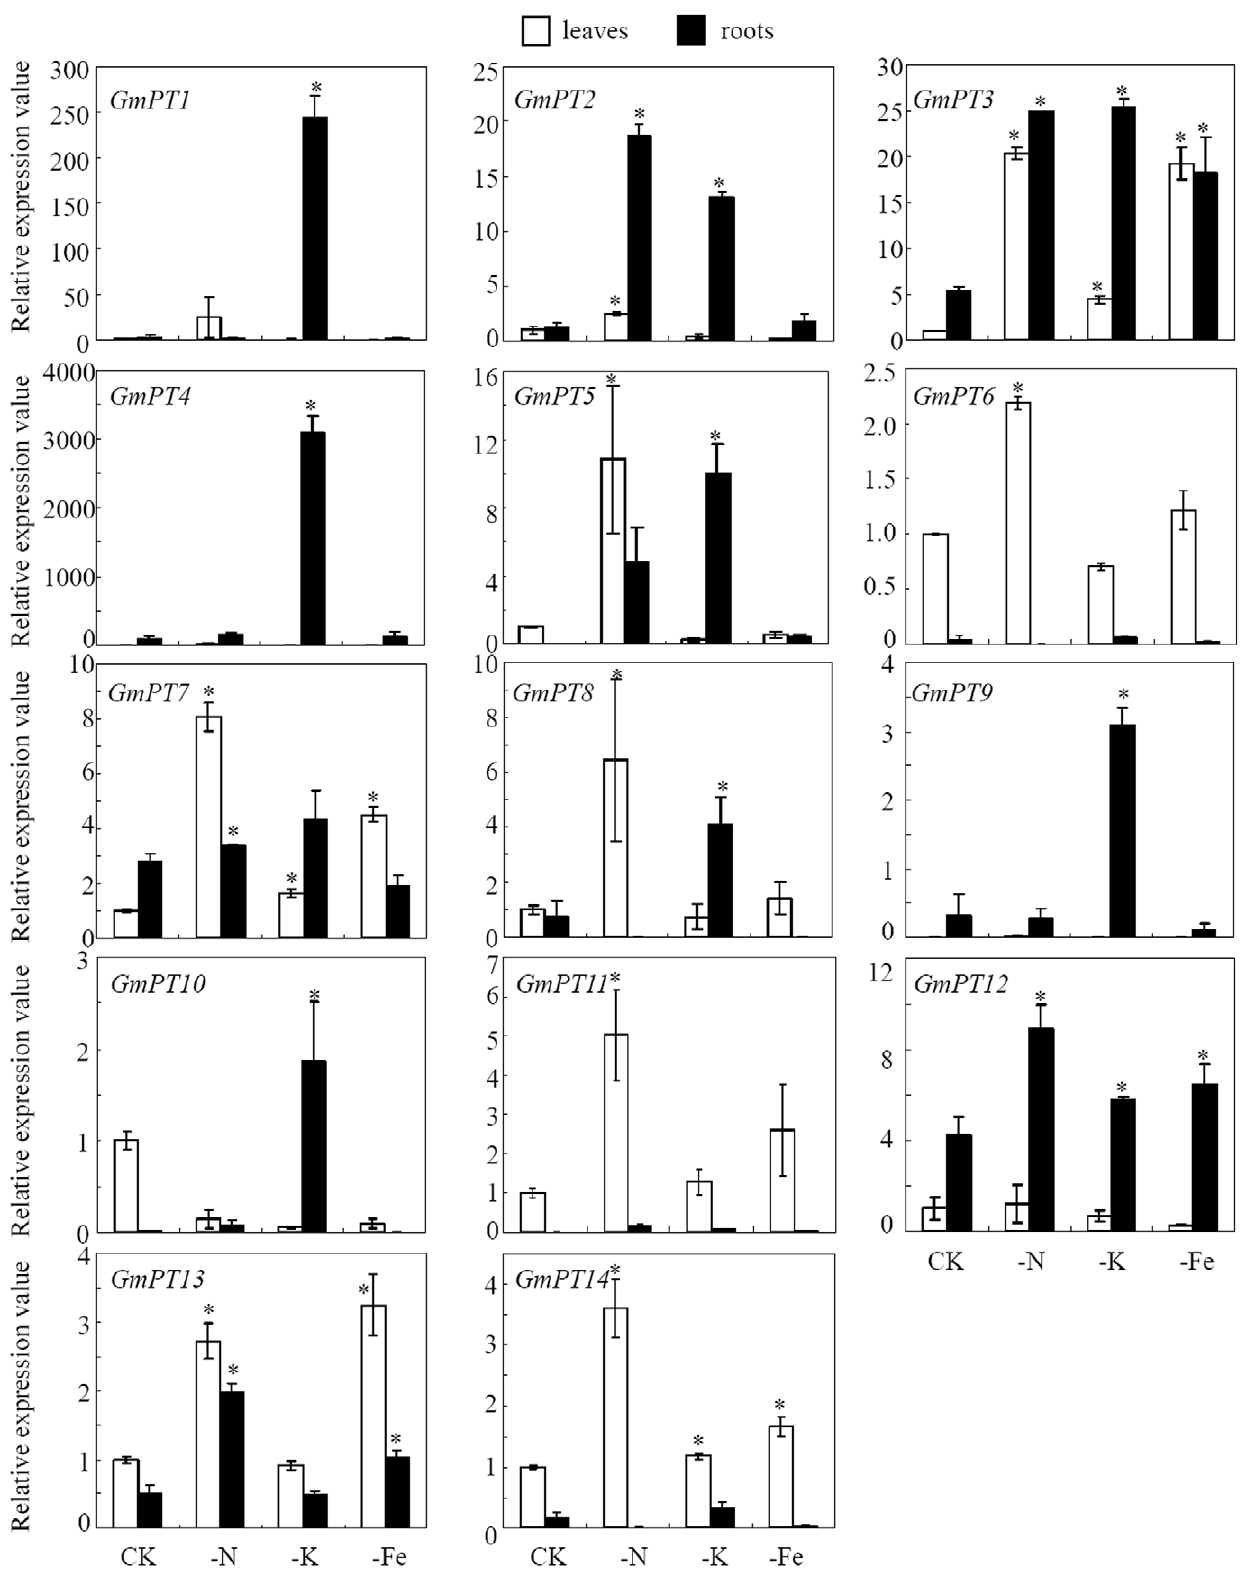
Figure 6. Responses of GmPTs to different nutrient stresses. Ten-day old soybean seedlings were treated with N ( 2 N), K ( 2 K) and Fe ( 2 Fe) deficiencies (see Experimental procedures for details). Seedlings grown under normal solution were used as controls (CK, added 500 m M P as KH 2 PO 4 ). Asterisks indicated the significant differences of GmPTs expression between nutrients deficient stresses and normal conditions in Student’s t-tests.